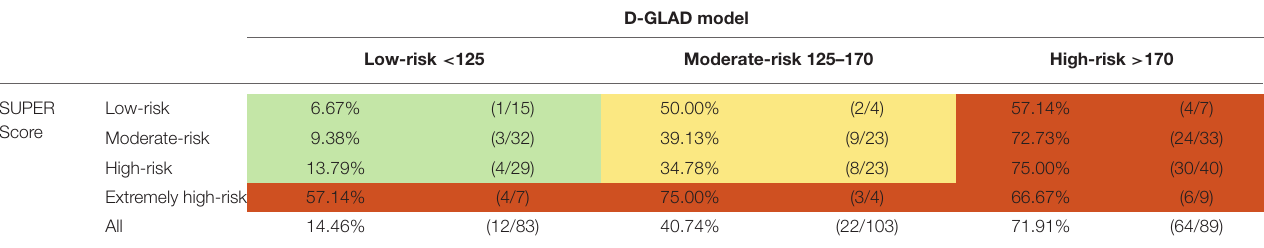
TABLE 3 | Predictive value of D-GLAD model and SUPER score for in-hospital